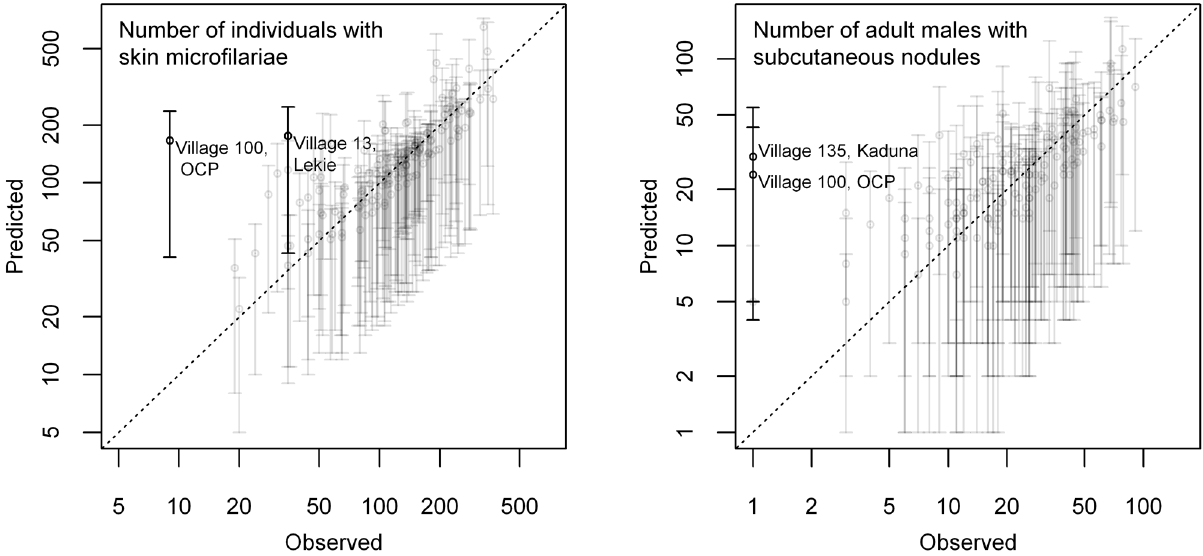
Figure 4. Comparison of observations (x-axis) versus model predictions (y-axis). The comparison was made by means of mixed posterior predictive checks of the numbers of individuals with detectable microfilariae in the skin and adult males with nodules. The dotted diagonal line represents the hypothetical perfect model fit. Error bars represent the 95% Bayesian prediction interval for the numbers of adult males with nodules and individuals with detectable microfilariae in the skin each village, and should intersect with the diagonal line if the model fit is good.